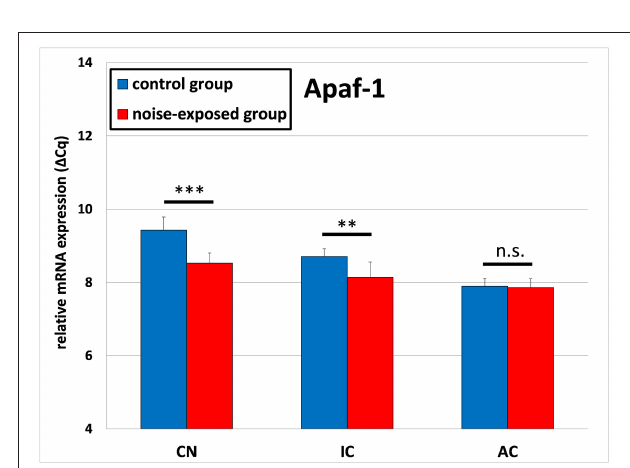
FIGURE 2 | Relative mRNA expression of Apaf1 . Presented are 1 Cq values (mean ± S.D.) in the cochlear nucleus (CN), inferior colliculus (IC) and auditory cortex (AC) of the mouse central auditory pathway immediately after noise trauma compared to unexposed controls. Asterisks indicate significant differences between control and trauma group (** p < 0.01; *** p < 0.001; n.s., no significant difference between groups).